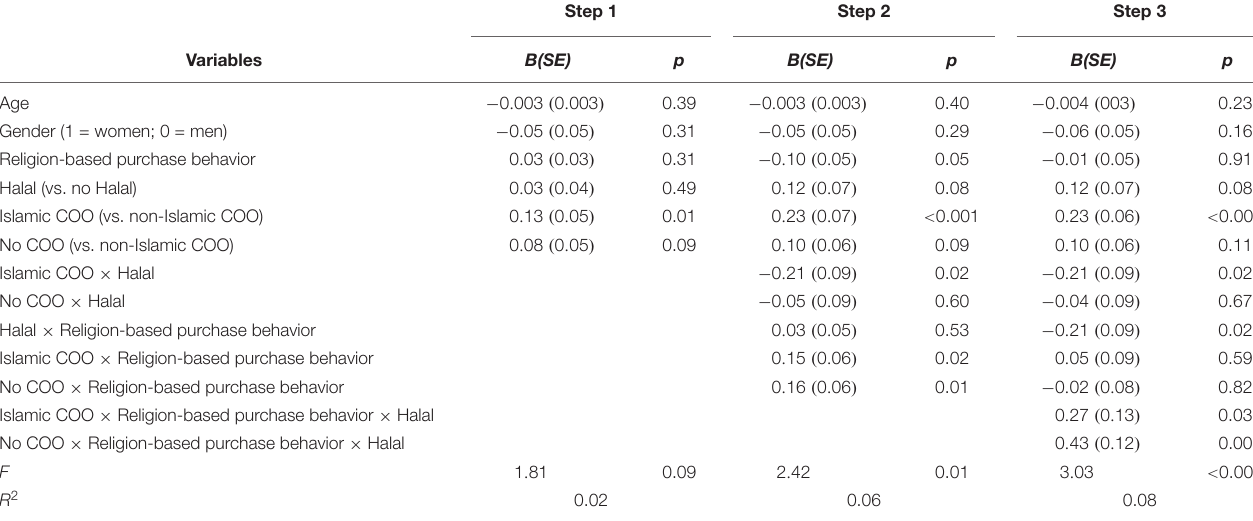
TABLE 1 | Predictors of positive product